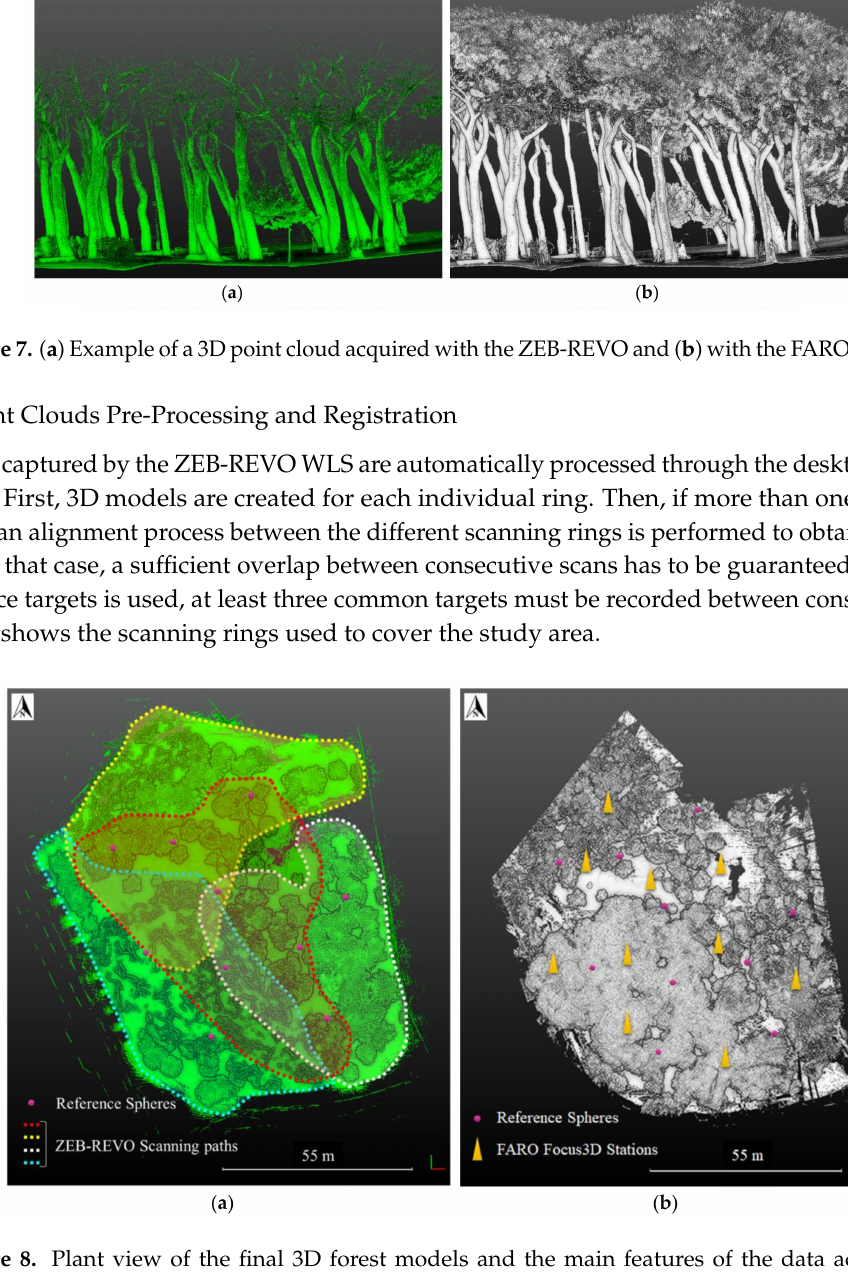
Figure 8. Plant view of the final 3D forest models and the main features of the data acquisition performed in the San Antonio Park (Section 3) with both sensors: ( a ) the ZEB-REVO wearable laser scanning (WLS) device and ( b ) the FARO Focus3D terrestrial laser scanning (TLS)